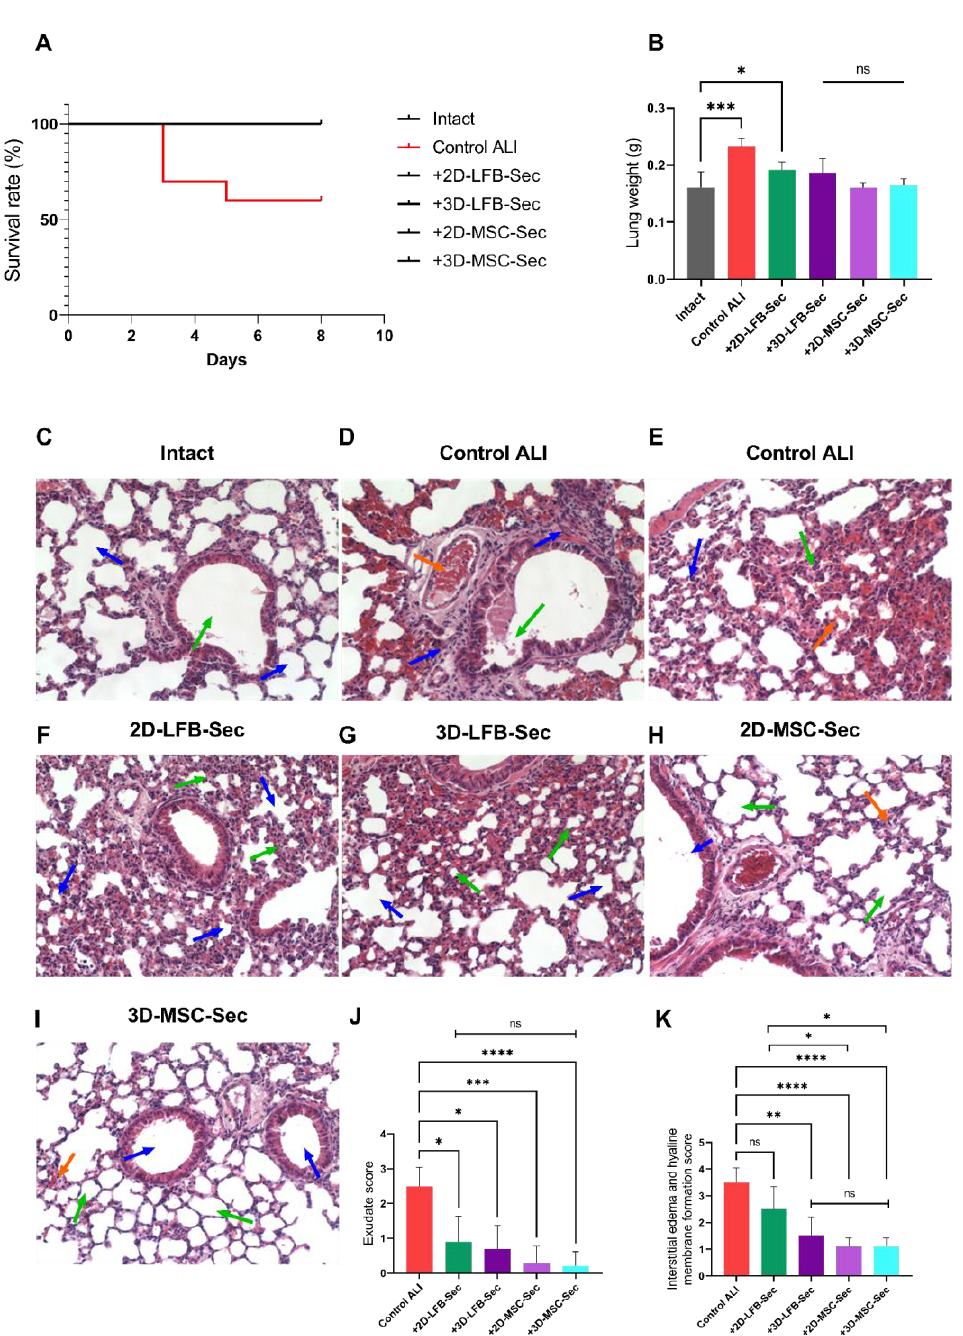
Figure 6. Survival analysis and histology examination of the lungs. ( A ) Survival of control, untreated lipopolysaccharide (LPS)-induced acute lung injury (ALI) mice, and LPS-induced ALI mice receiving 2D-LFB-Sec, 3D-LFB-Sec, 2D-MSC-Sec, and 3D-MSC-Sec for up to 8 days after LPS instillation ( n = 10 for each group at the beginning of the experiment). ( B ) Lung weight on day 8 after ALI induction. Data are presented as the mean ± SD for each condition ( n = 6–10). *** , adjusted p = 0.006 for Intact vs. Control ALI, *, adjusted p = 0.0323 for Intact vs. 2D-LFB-Sec, (ns) represents a nonsignificant difference for Intact vs. 3D-LFB-Sec, 2D-MSC-Sec and 3D-MSC-Sec. ( C ) Histology examination of the lungs for the Intact group. The blue arrows indicate the alveoli; the green arrow indicates bronchial lumen. ( D , E ) Histology examination of the lungs for the Control ALI group. The blue arrows indicate areas of infiltration and alveolar decline; the green arrows indicate epithelial disorders and edema of the stroma of the alveoli; orange arrows indicate accumulation of exudate and thrombosis. ( F ) Histology examination of the lungs for the 2D-LFB-Sec group. Blue arrows indicate